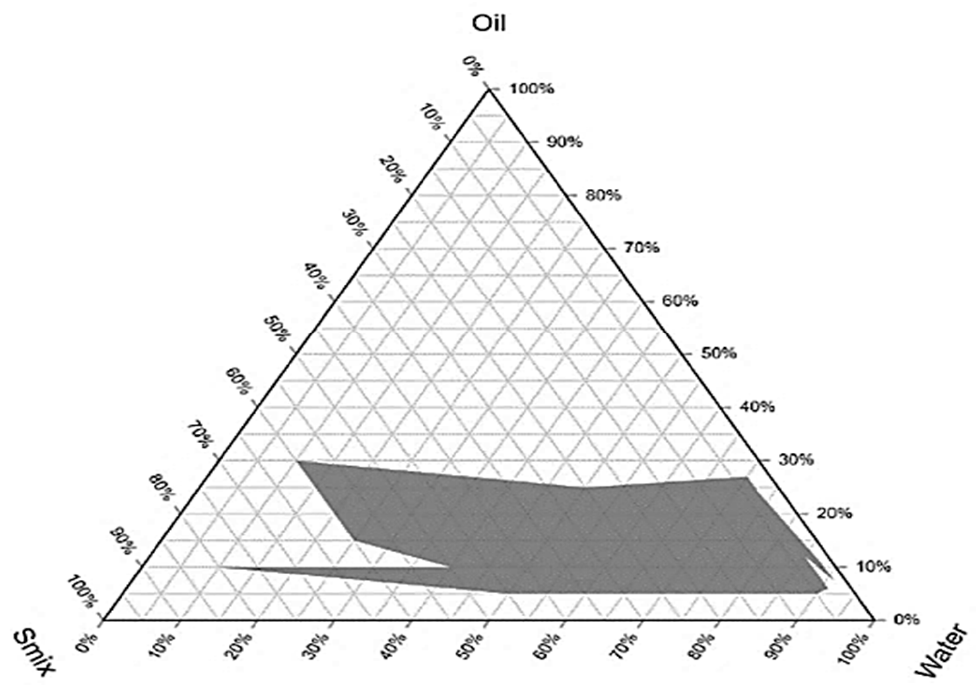
Figure 1. Pseudo ternary phase diagram.